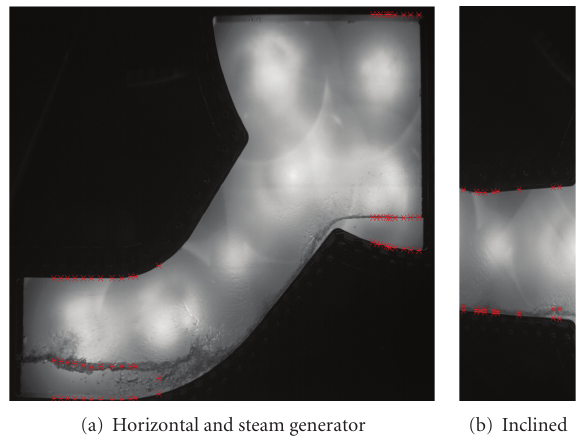
Figure 5: Detected water level and boundaries of the hot leg channel (steam-water).